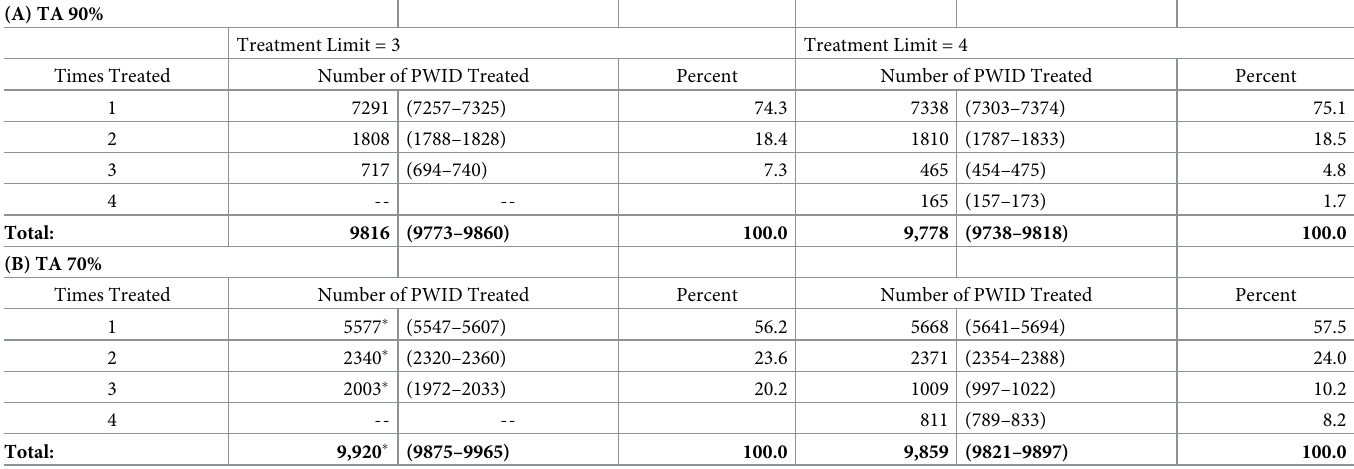
Table 3. Mean PWID treatment enrollment frequency (95% CI) for DAA treatment rate of 7.5% per year with 1–3 (Treatment Limit = 3) or 1–4 (Treatment Limit = 4) DAA courses permitted, and treatment adherence (TA) of 90% (A) and 70% (B). Number treated values are rounded to the nearest integer. Percent treated is the fraction of PWID treated by number of times in each row relative to the total number of all individual PWID treated. The related DAA cost is shown in Table 4 . Entries marked with ( � ) indicates scenario does not achieve WHO incidence elimination